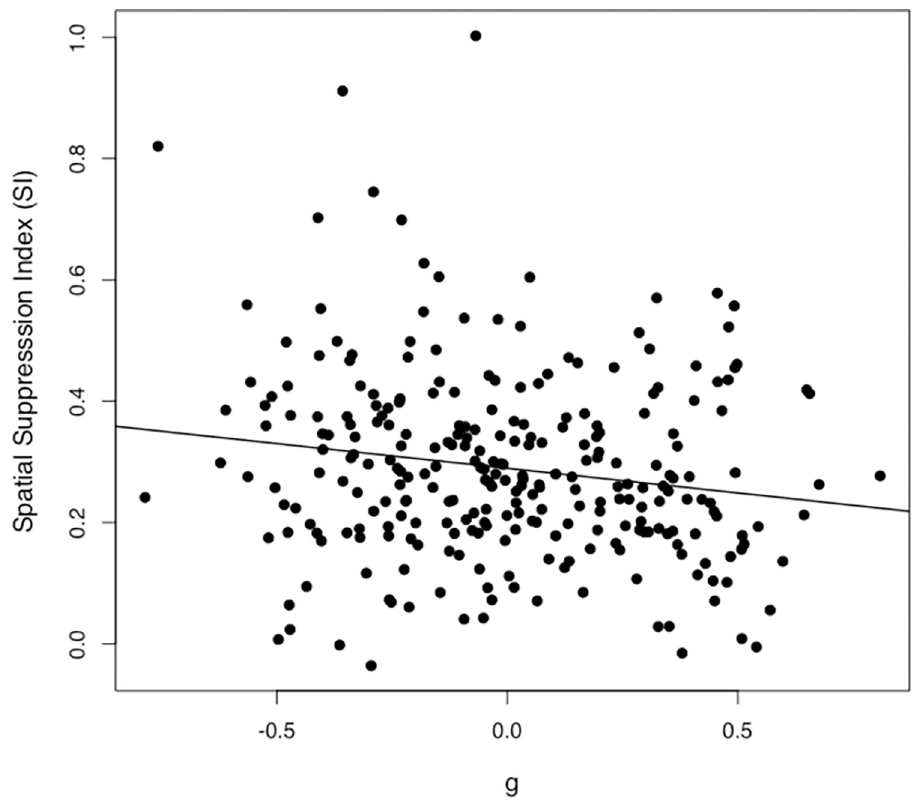
Fig 2. Scatterplot of the relationship between spatial suppression (spatial suppression index) and g in 273